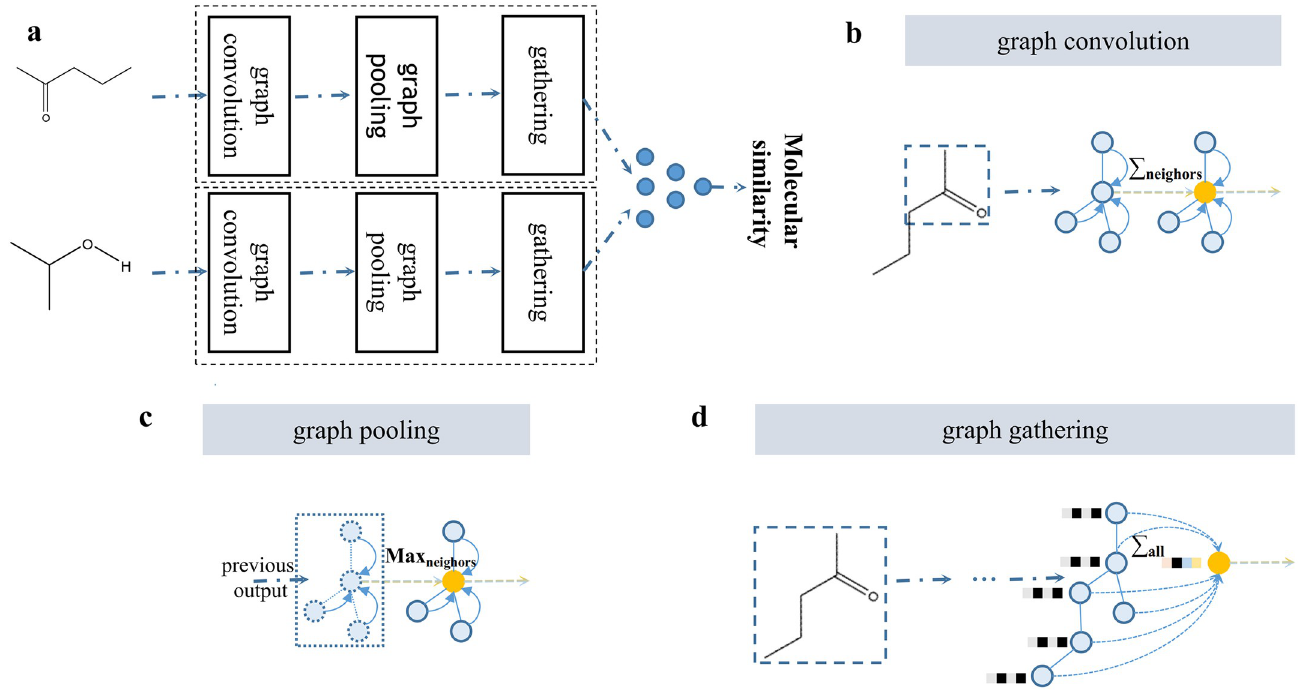
Fig 3. A graphical representation of the network described in this article. a Siamese graph convolutional neural network with shared weights, b graph convolution operation, c graph pooling operation, and d graph gathering operation in the network.